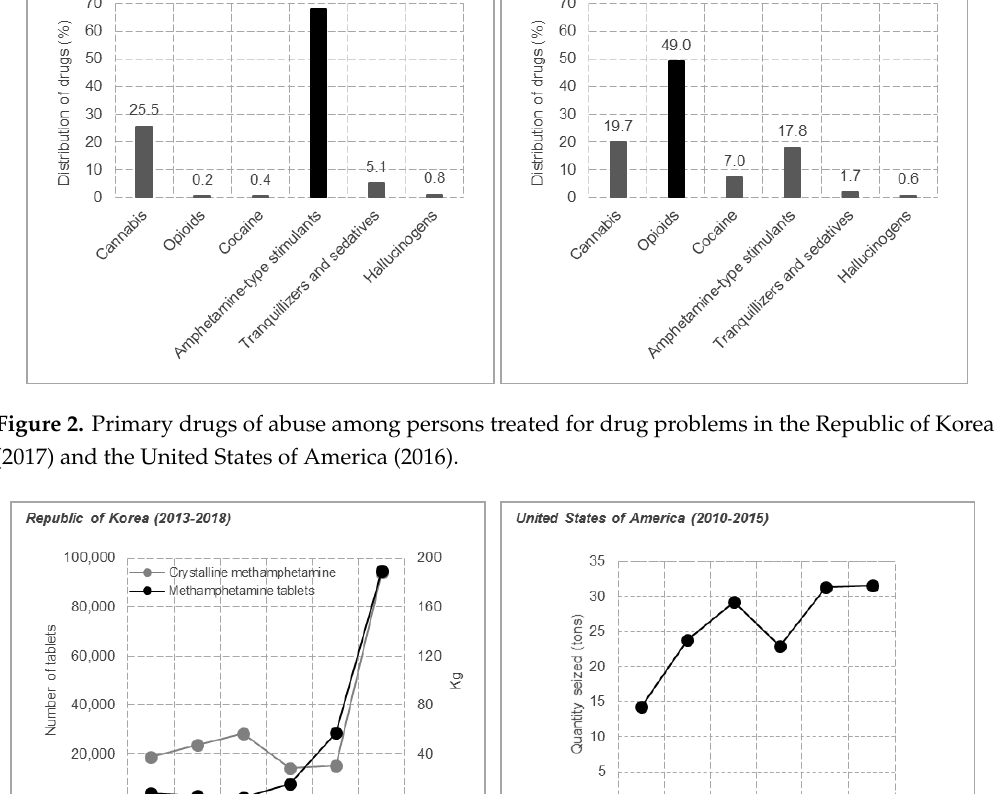
Figure 3. Methamphetamine-induced seizures in the Republic of Korea (2013 – 2018) and the United States of America (2010 – 2015).